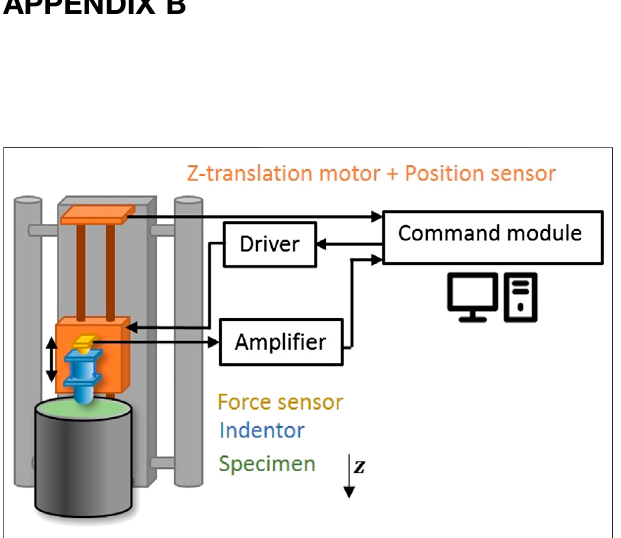
FIGURE 6 | Illustration of the indentation